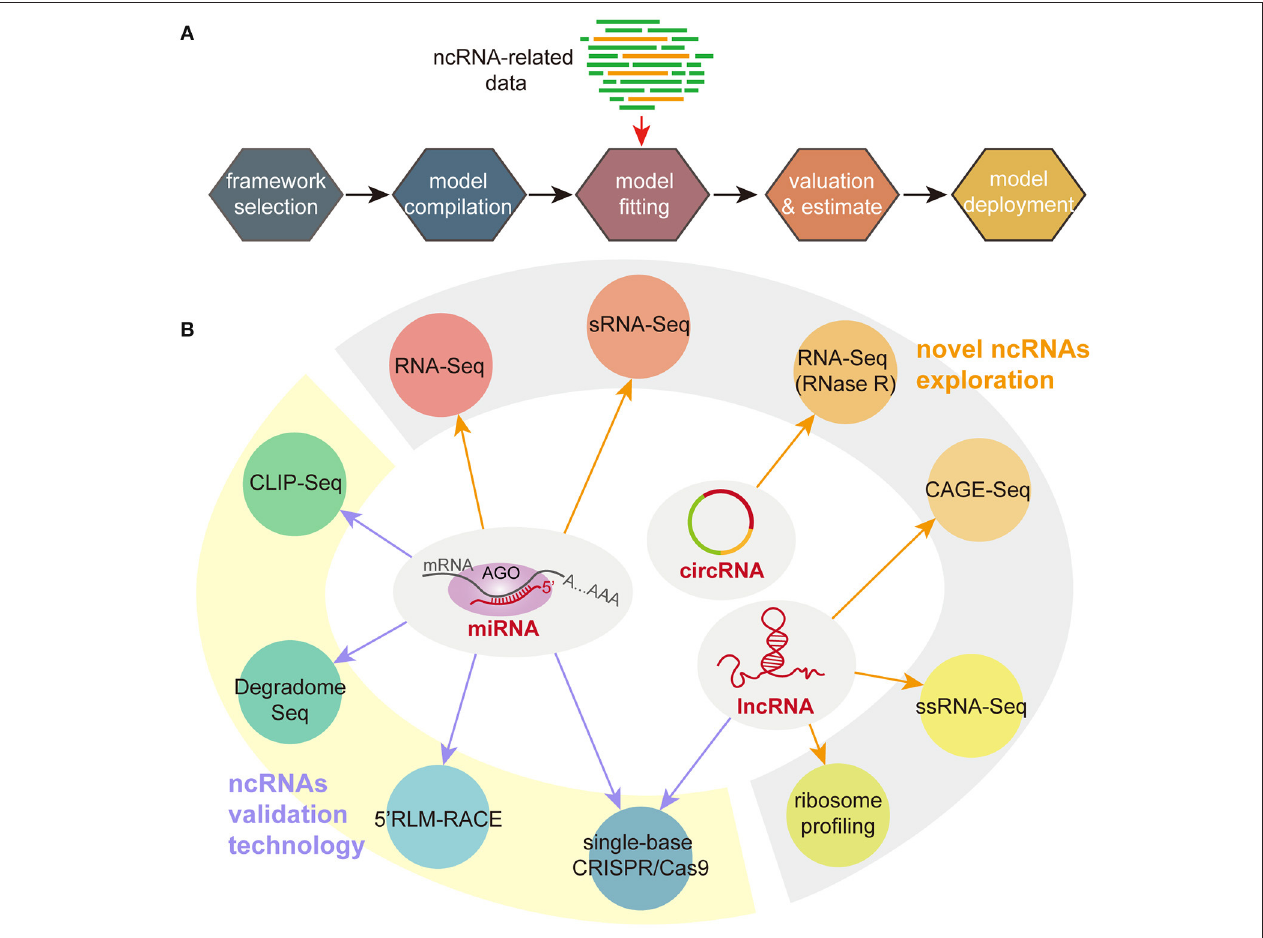
FIGURE 1 | Deep learning processes (A) and experimental techniques (B) for studying ncRNAs. sRNA-Seq, small RNA sequencing; CLIP-Seq, crosslinking and immunoprecipitation with sequencing; 5 ′ RLM-RACE, 5 ′ RNA ligase mediated amplification of cDNA ends; ssRNA-Seq, strand-specific RNA sequencing; CAGE-Seq, cap analysis gene expression